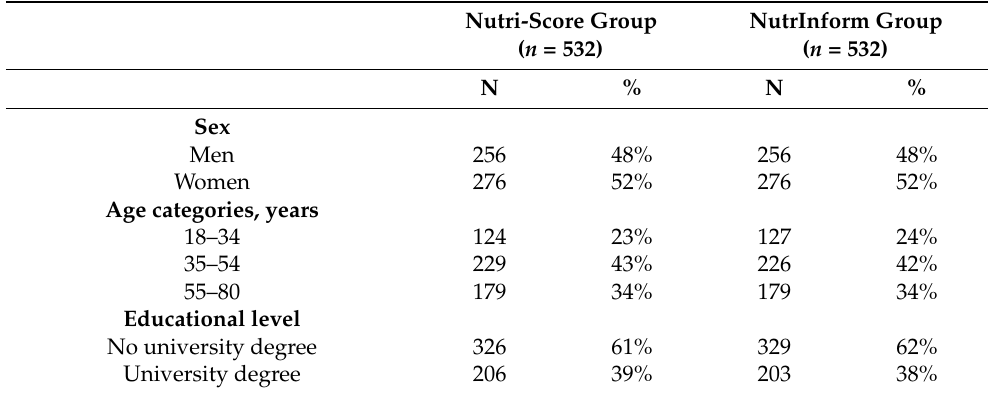
Table 1. Individual characteristics of participants, context and understanding of the information note per randomization group ( n =